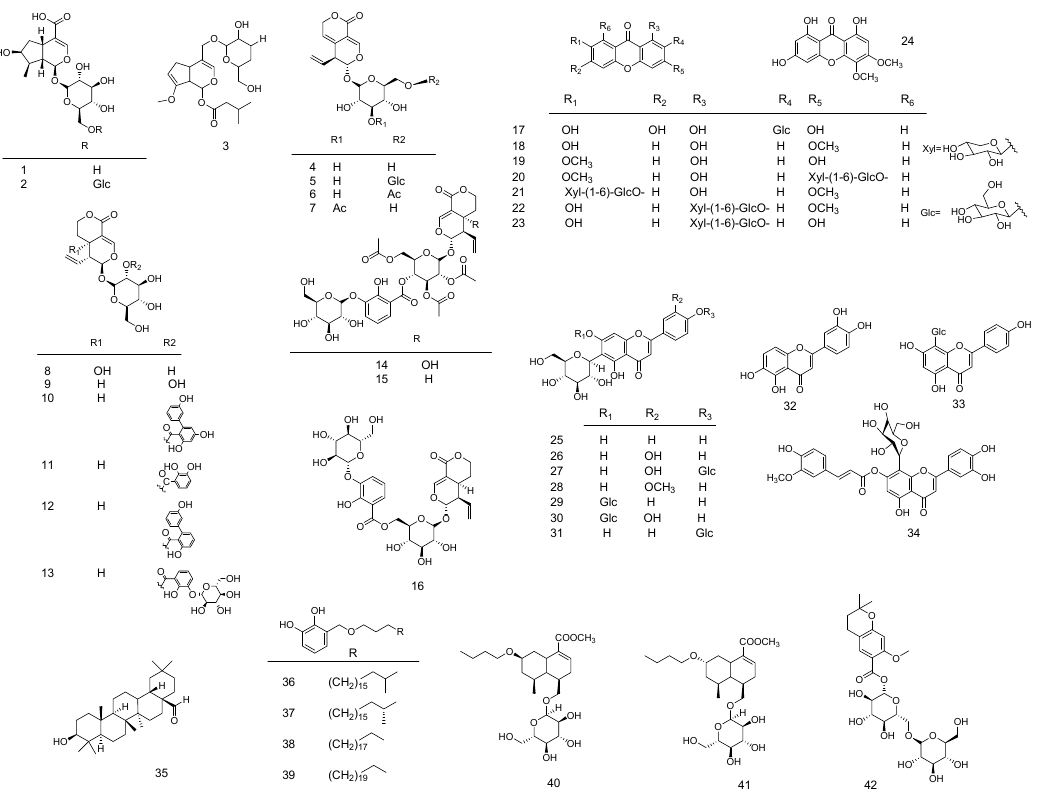
Figure 2. The structure of all compounds that were detected.